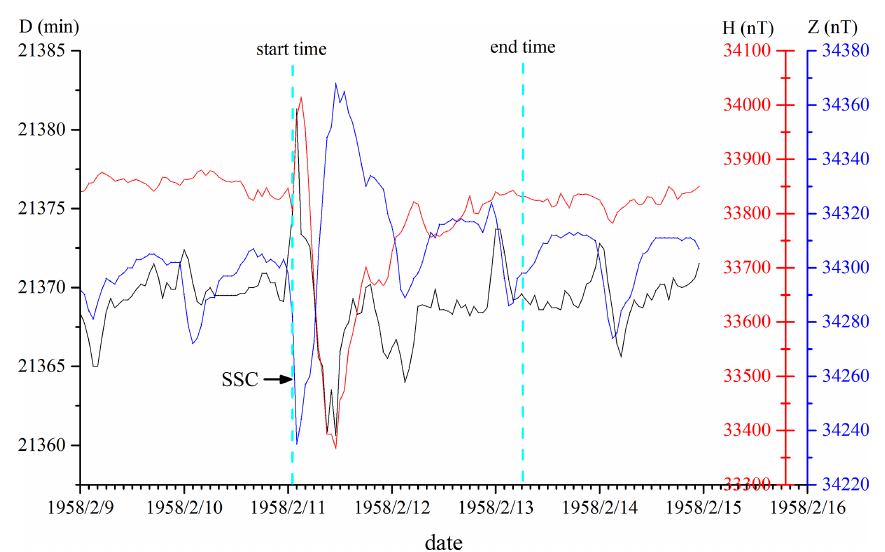
hourly mean value (AHMV) data are available at: https://doi.org/10.5281/zenodo.7005471 et